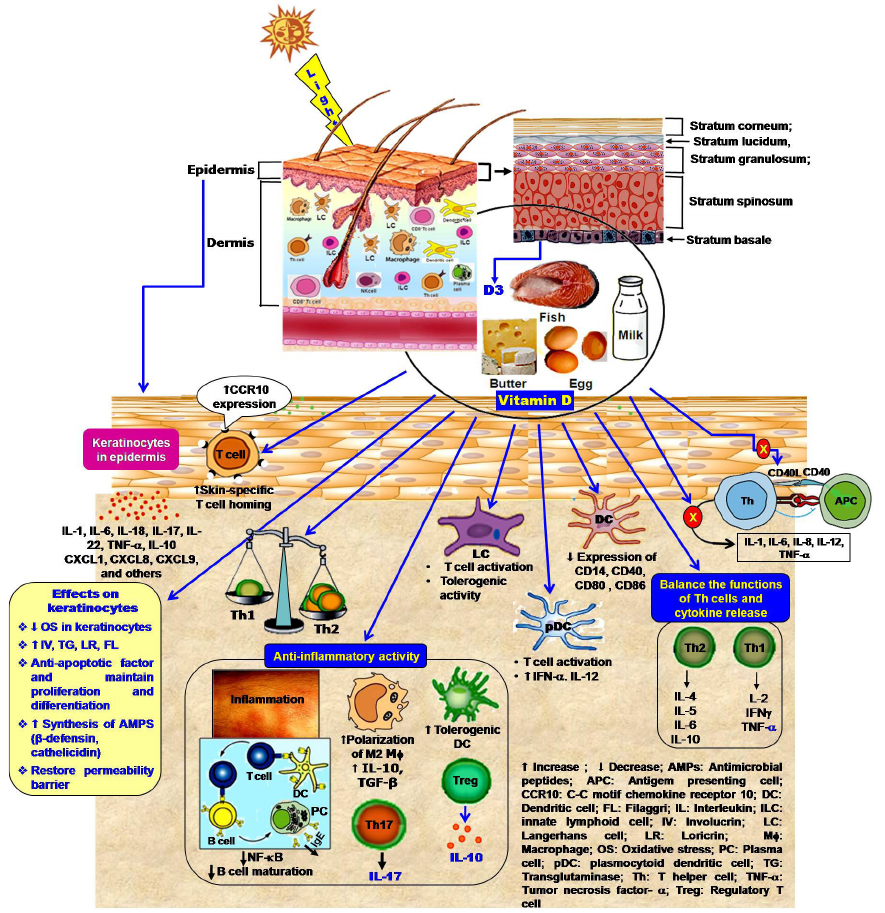
Figure 2. Immunomodulatory effects of vitamin in the cutaneous immune compartment. 1,25(OH)2 vitamin D polarizes the Th2 development and maintains a balance in cytokine secretion. Active vitamin D regulates the inflammatory response by inhibition of Th17 cell development and facilitation of Treg cell generation, formation of tolerogenic DC, the release of IL-10, and suppression of IgE synthesis. Vitamin D also inhibits the expression of the co-stimulatory molecule on DCs and blocks the activation of Th cells, as well as cytokine production. Moreover, vitamin D facilitates the skin-homing capacity of